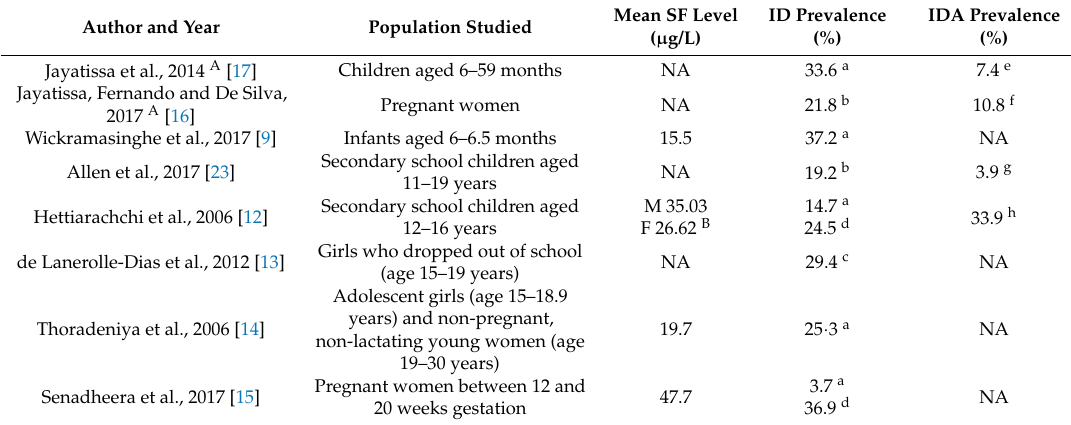
Table 3. Prevalence of ID and IDA in Sri